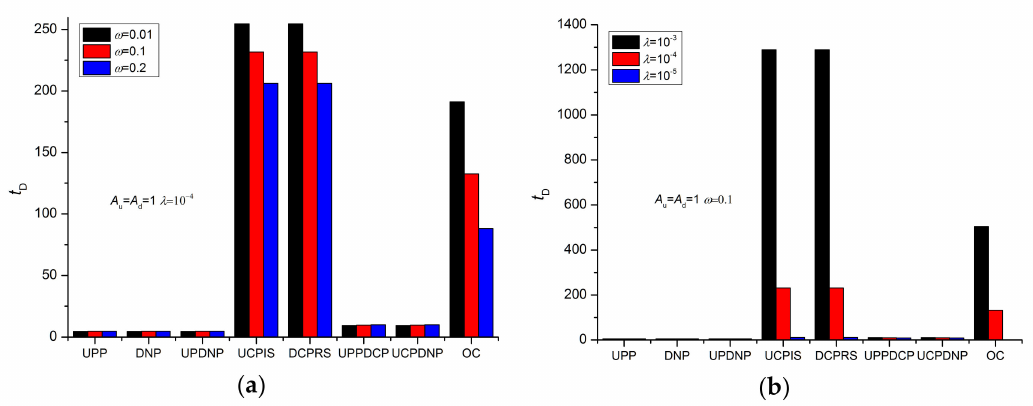
Figure 11. Upstream and downstream pressure equilibrium times: ( a ) storativity ratio; ( b ) interporosity flow coe ffi cient.